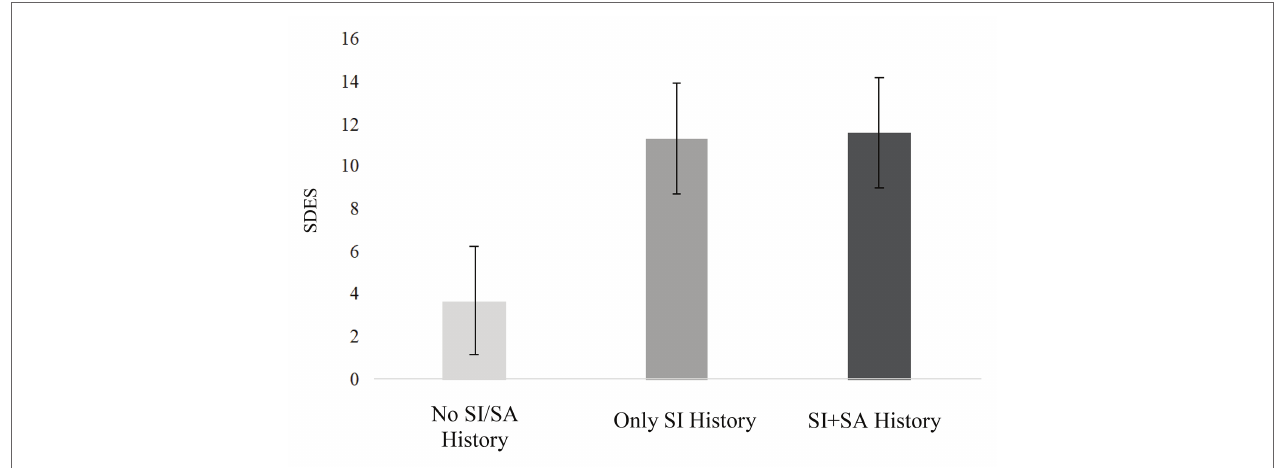
FIGURE 1 | Differences in defeat/entrapment across suicidal and nonsuicidal adolescents. SDES, Short Defeat and Entrapment Scale; No SI/SA History, no history of suicidal ideation or attempt; Only SI History, history of suicidal ideation but not attempt; SI+SA History, history of suicidal ideation and suicide attempt. Error bars represent standard error.